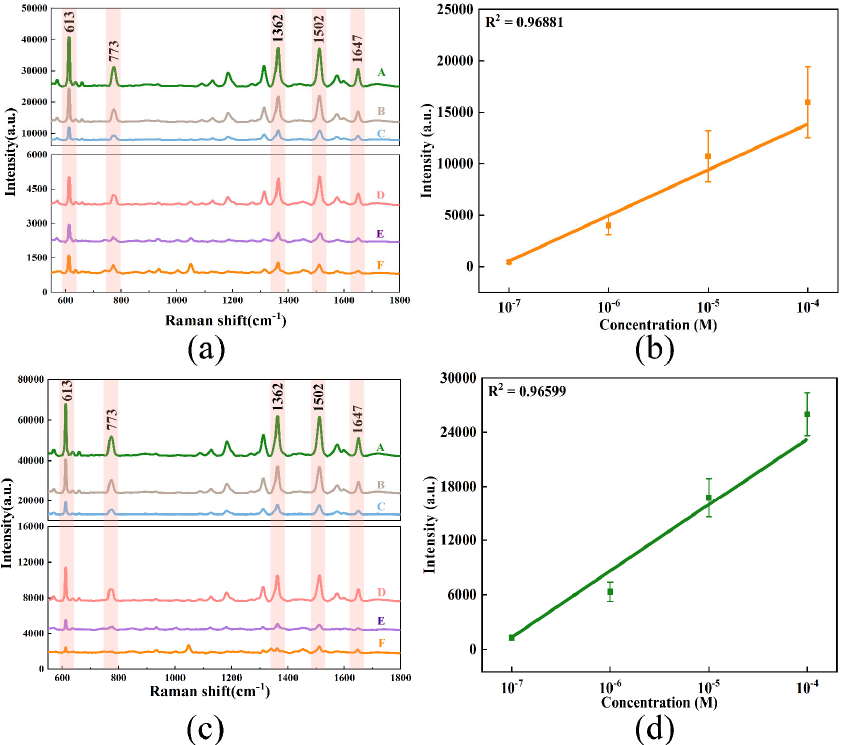
Figure 4. SERS spectra of R6G (A-F:10 − 4 M–10 − 9 M) adsorbed on the flower-like silver particles ( a ) and quasi-spherical silver particles ( c ) with the average intensity of the SERS signals; at 613 cm − 1 as a function of the linear relationship of R6G concentration ( b,d ).